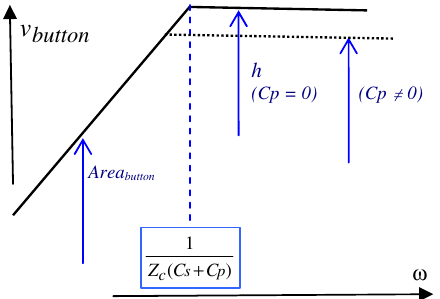
FIG. 2. (Color) Asymptotes of the button transfer function. The gain is proportional to the distance h at high frequencies and to the electrode surface at low frequencies. The cutoff frequency is a function of the total capacitance. A modification of the area and/or h changes also the capacitance and therefore the cutoff frequency.